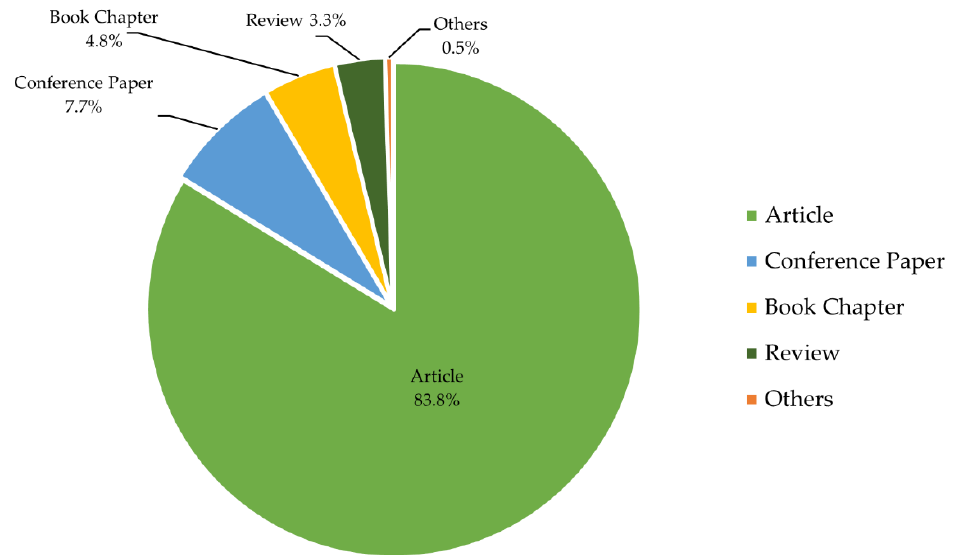
Figure 3. Distribution of scientific production according to the type of document.